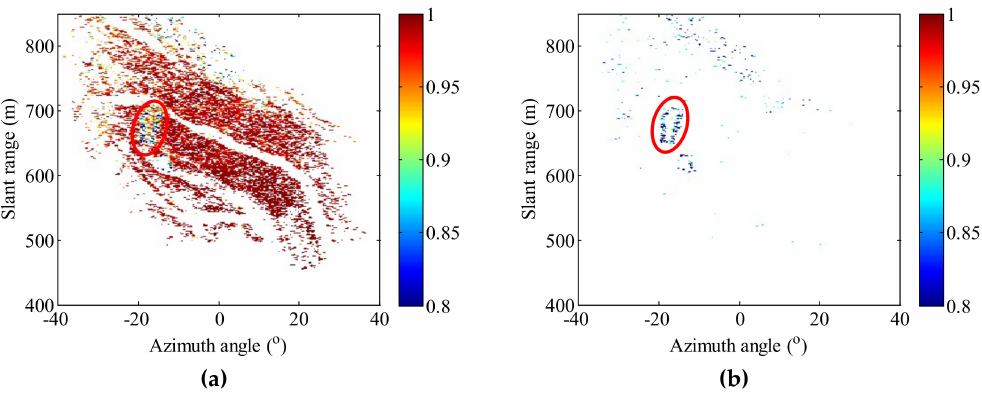
( 30 ) of Group B. ( b ) PSs with B